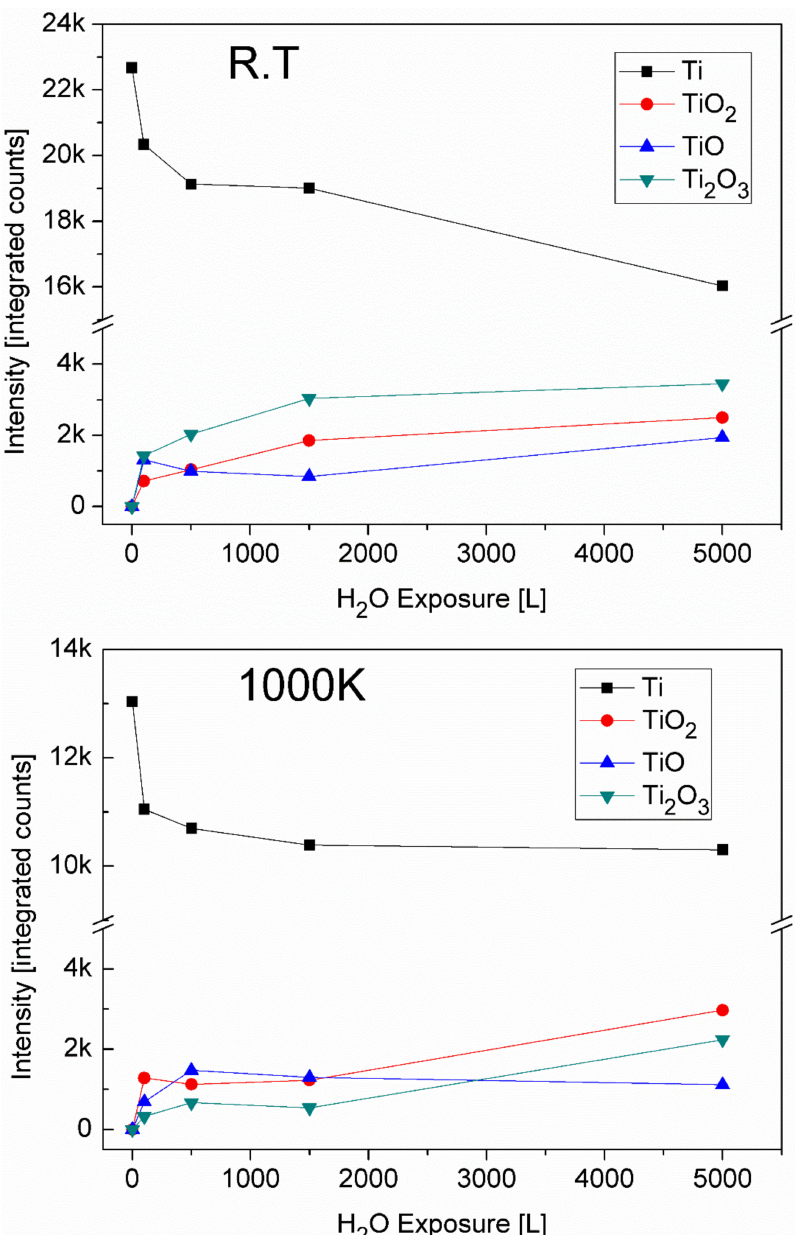
Figure 12. The change in the intensity of the Ti and its oxides during H 2 O exposure at RT and 1000